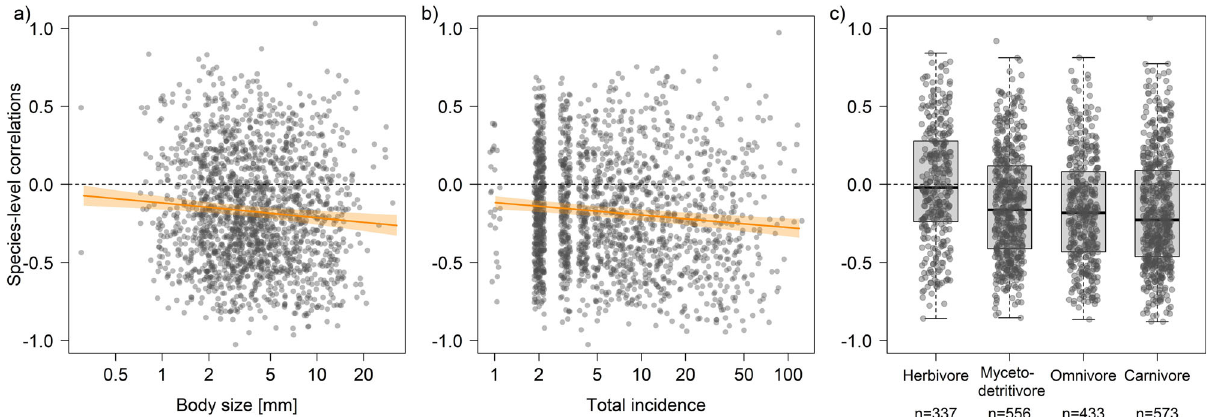
Fig. 5 Results for species-level correlations and traits. Species-level correlations decline with a body size and b total incidence of each species per region. Correlations (shown as partial residuals of Pearson ’ s r between year and the number of individuals per species in a region, excluding single occurrences) varied among c trophic groups, with the majority of the species in all groups except herbivores having negative values on average. Numbers in c indicate species*region combination for each trophic group (center lines in boxplots specify the median, boxes cover the range between the lower and upper quartile, whiskers extend to 1.5x interquartile range). Statistical details are given in Supplementary Tables 3 and 4. Regression lines (95% CI in shaded polygons) indicate the marginal predictions of a linear mixed-effects model. Dashed horizontal lines mark null with negative values indicating species with declining and positive values species with increasing individual numbers over